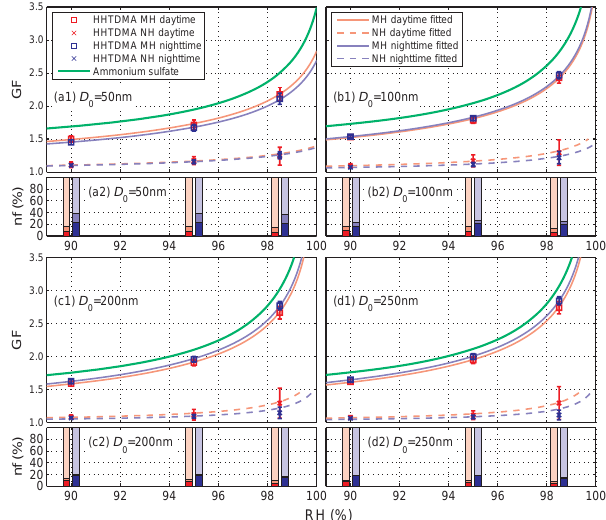
Fig. 6. (a1–d1) the hygroscopic growth of aerosol particles with different dry diameters of 50nm, 100nm, 200nm and 250nm, re- spectively. The growth factors (GF) of nearly-hydrophobic (NH) group and more-hygroscopic (MH) group are the mean values of the measured GFs corrected to their set RHs (90%, 95% and 98.5%); the error bars represent ± 1s. d.; the blue and red lines are fitted κ -K¨ohler curves using the mean κ measured by the HH-TDMA; the green lines are the hygroscopic growth of ammonium sulphate particles calculated following Low (1969) and Young and Warren (1992). (a2-d2) the mean number fractions of nearly-hydrophobic (NH) group, less-hygroscopic (LH) group and more-hygroscopic (MH) group particles (from dark colour to light colour) with 50nm, 100nm, 200nm and 250nm dry